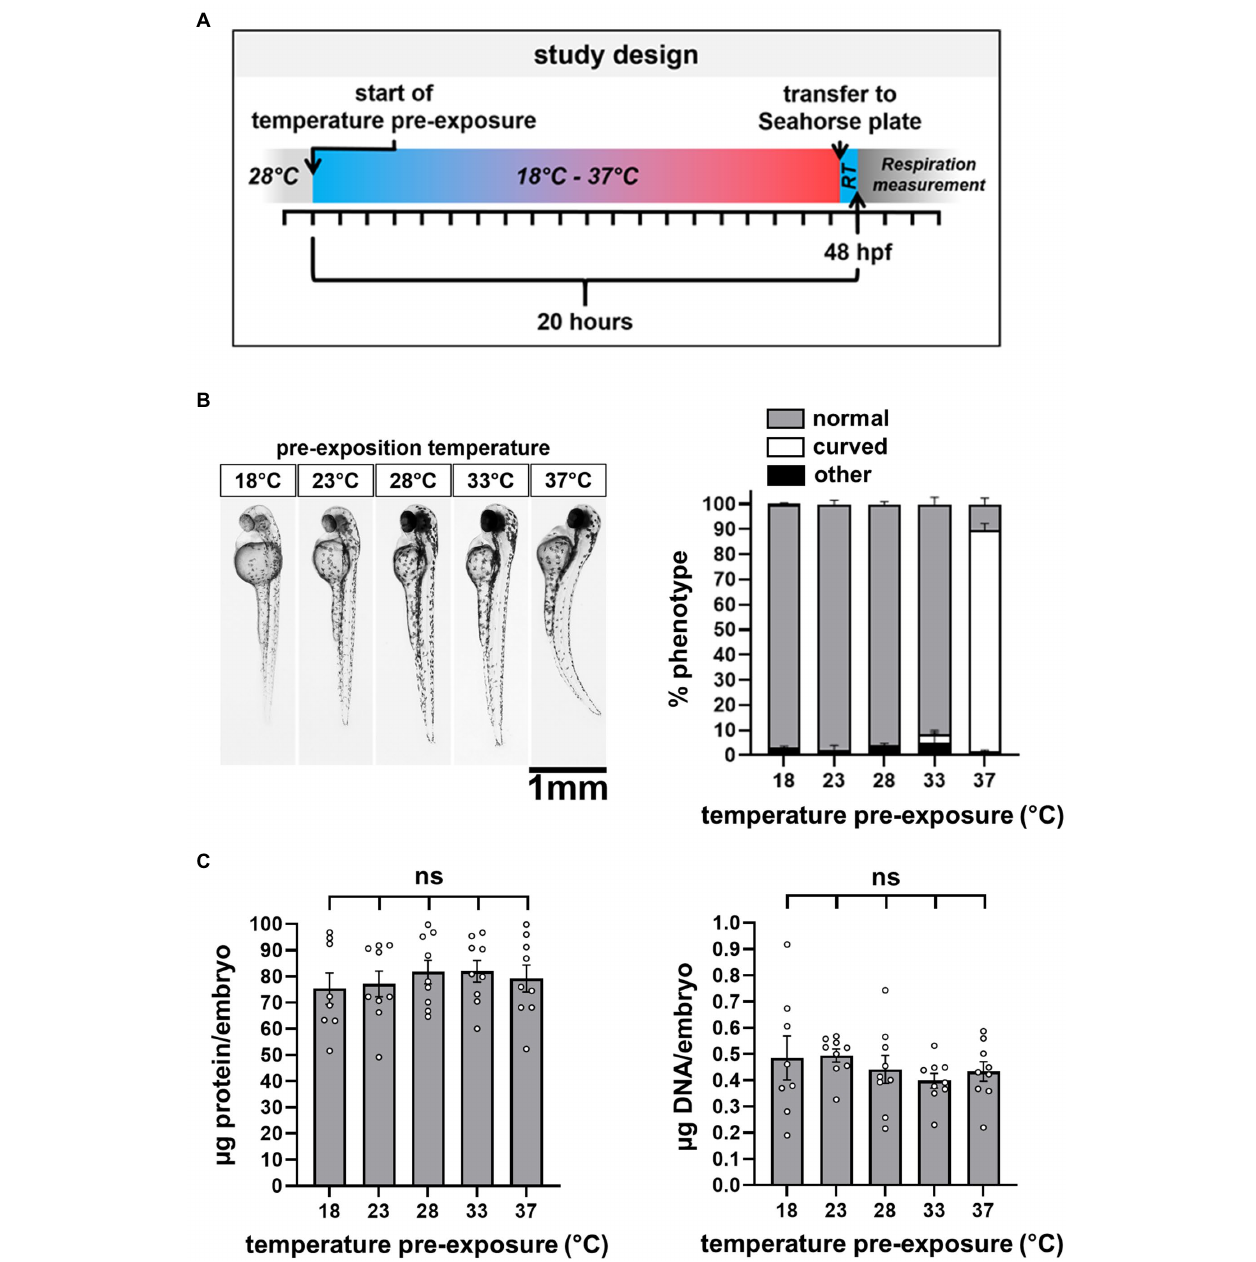
FIGURE 3 | Study design and temperature-dependent changes in embryo morphology. (A) Short outline of the study design. A comprehensive outline can be found in the Supplementary Figure . RT: room temperature of 22 ± 1 ° C. (B) Light microscopy to evaluate shape changes, categorized in normal, curved, and other. (C) Quantification of protein and DNA content per